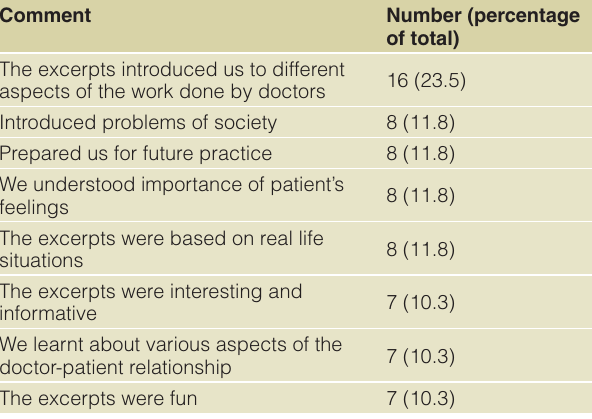
Table 2. Respondents’ comments about the use of literature excerpts in the